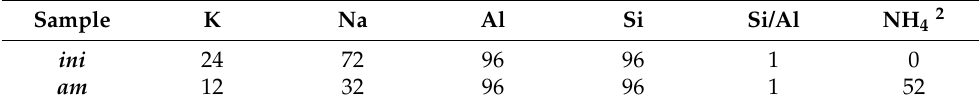
Table 1. Unit cell composition of the samples 1